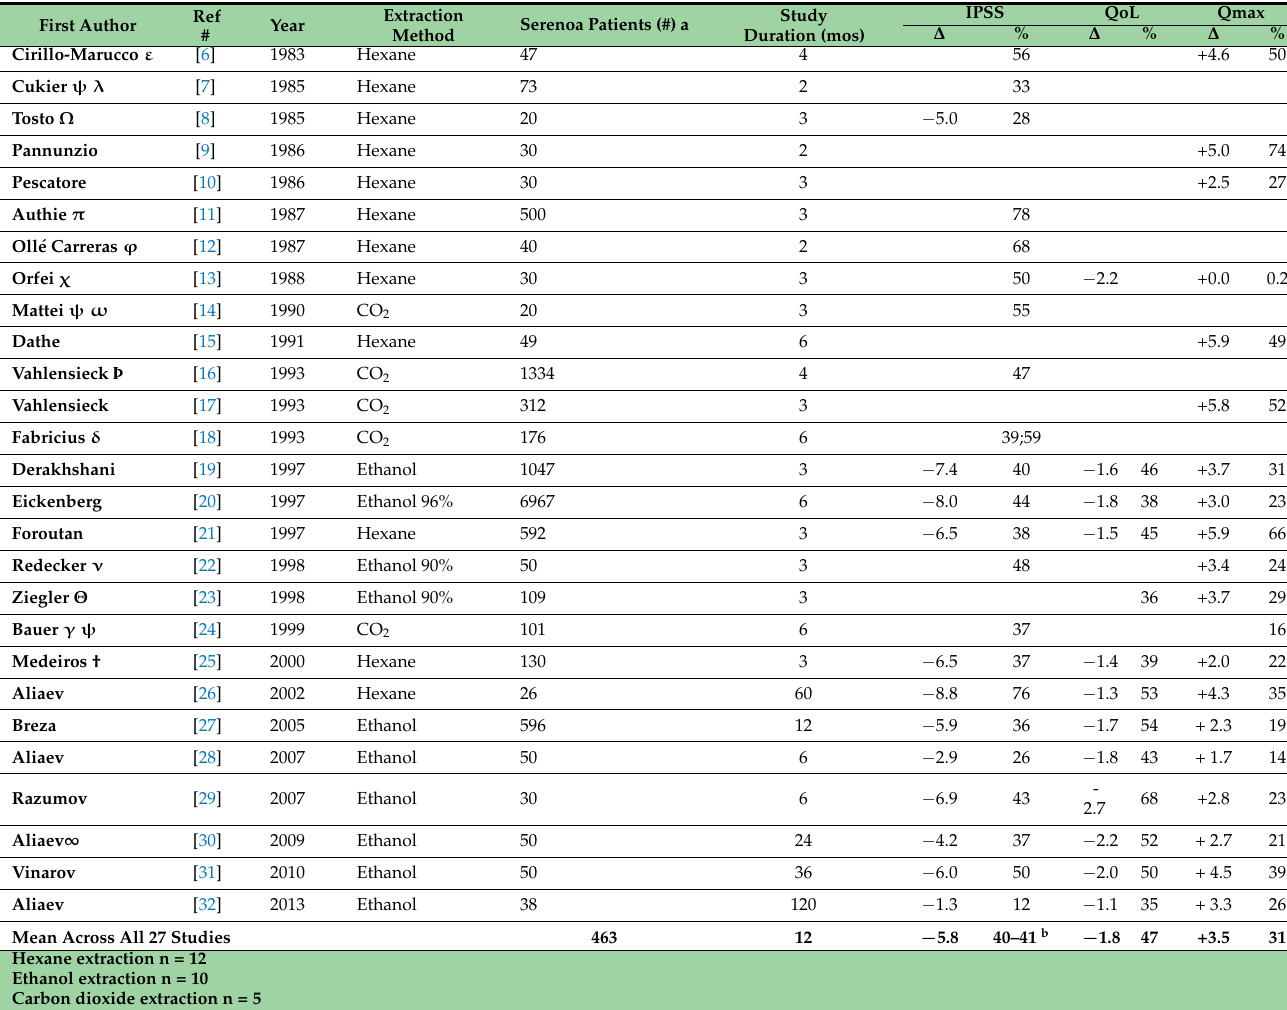
Table 1. Evaluable non-English-language papers (27 studies) were categorized by the extraction method, the average number of patients, the study duration, and the clinical endpoints IPSS, QoL, and Qmax. First